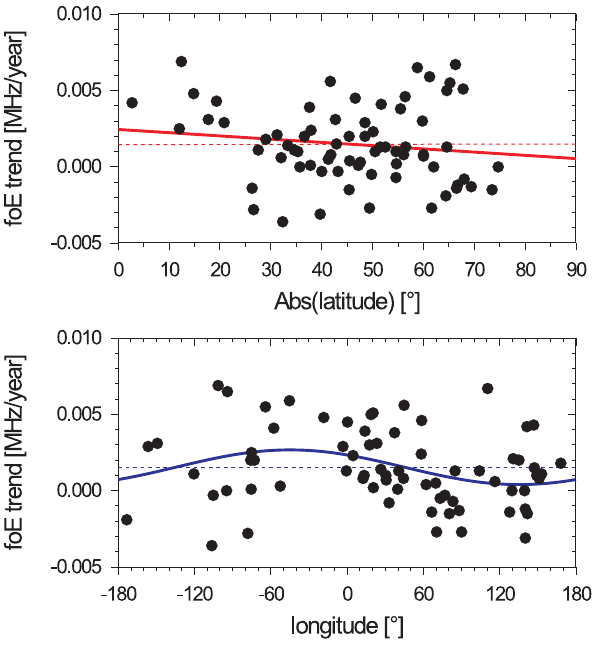
Fig. 7. Global mean h’E trend (left part) and histogram (right part) deduced from observations at 33 individual ionosonde stations.